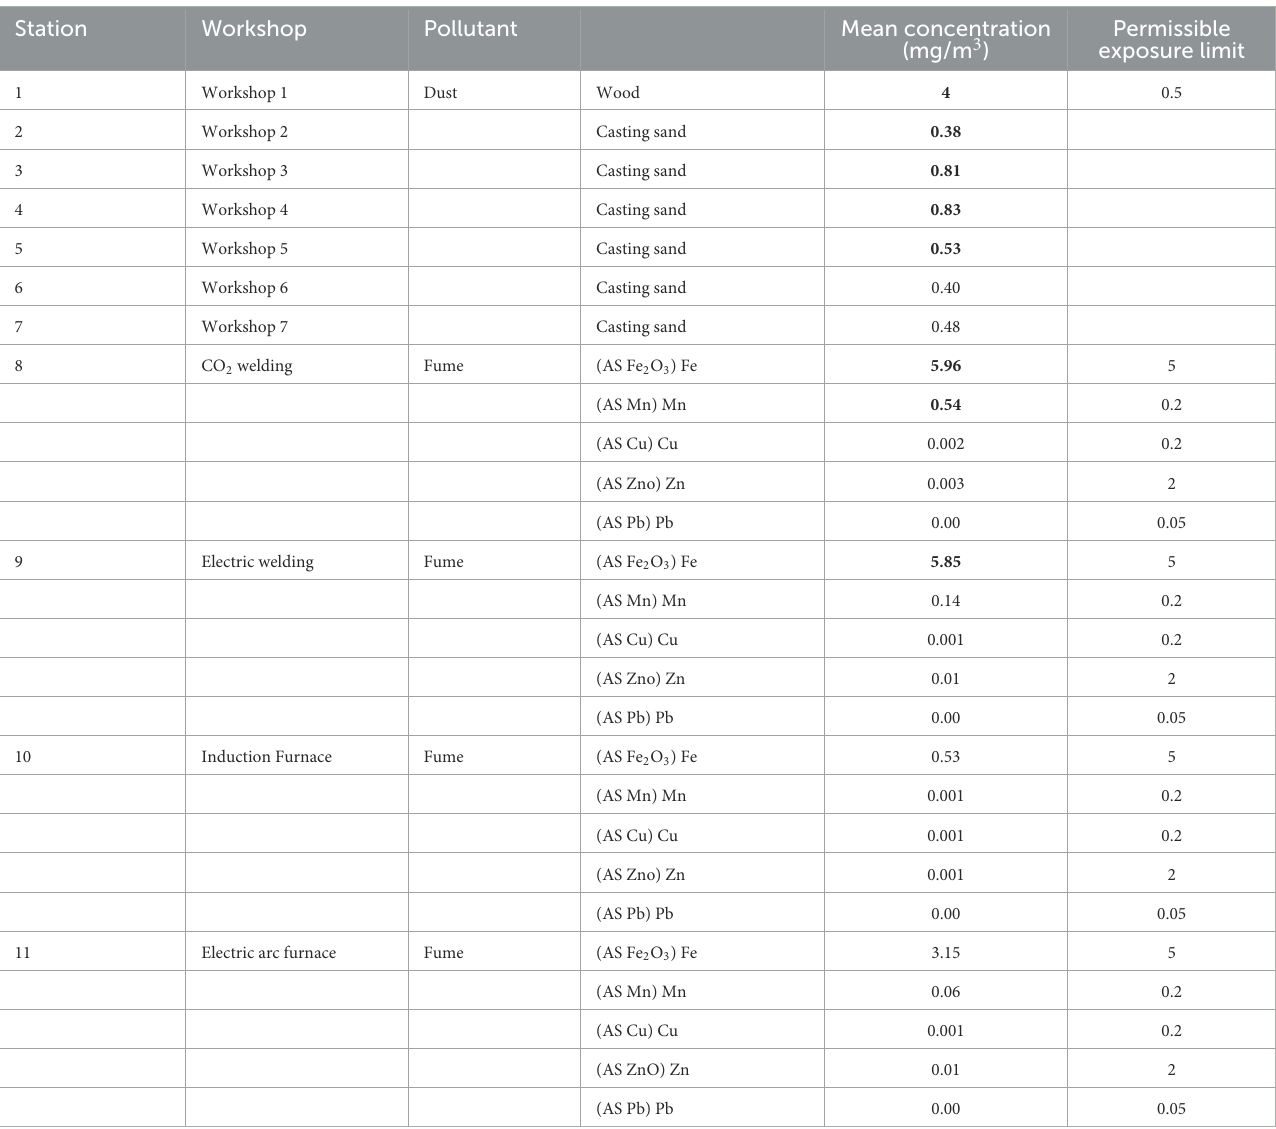
TABLE 2 Concentrations of dusts and fumes measured in 11 units of the company.